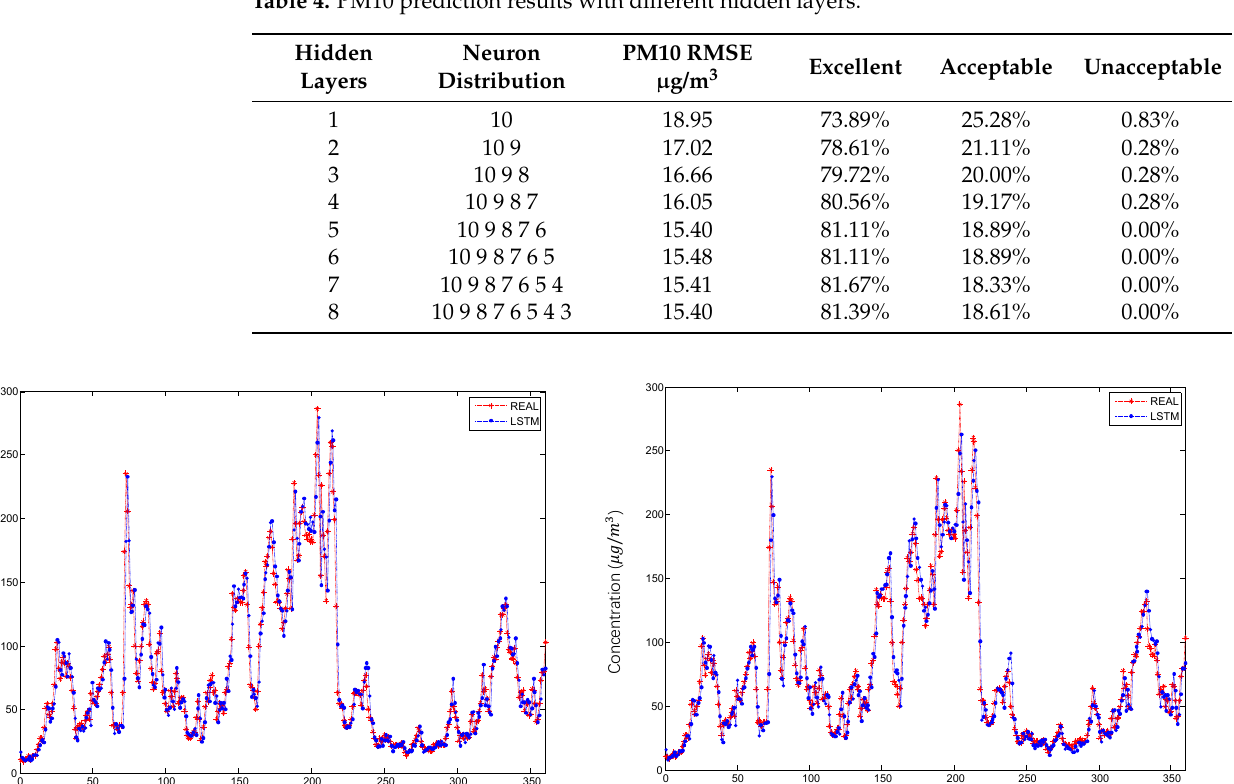
Table 4. PM10 prediction results with different hidden layers.